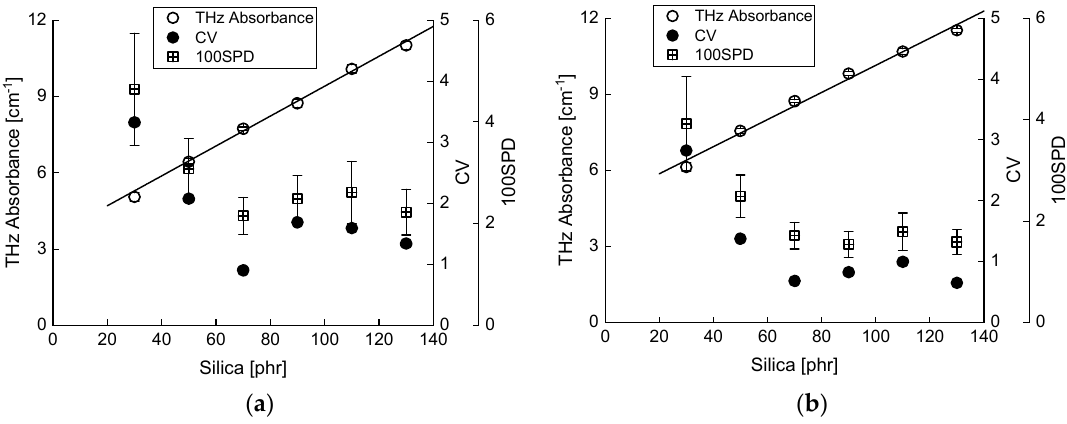
Figure 10. Calibration lines for the THz absorbance (solid line) against silica concentration with CV